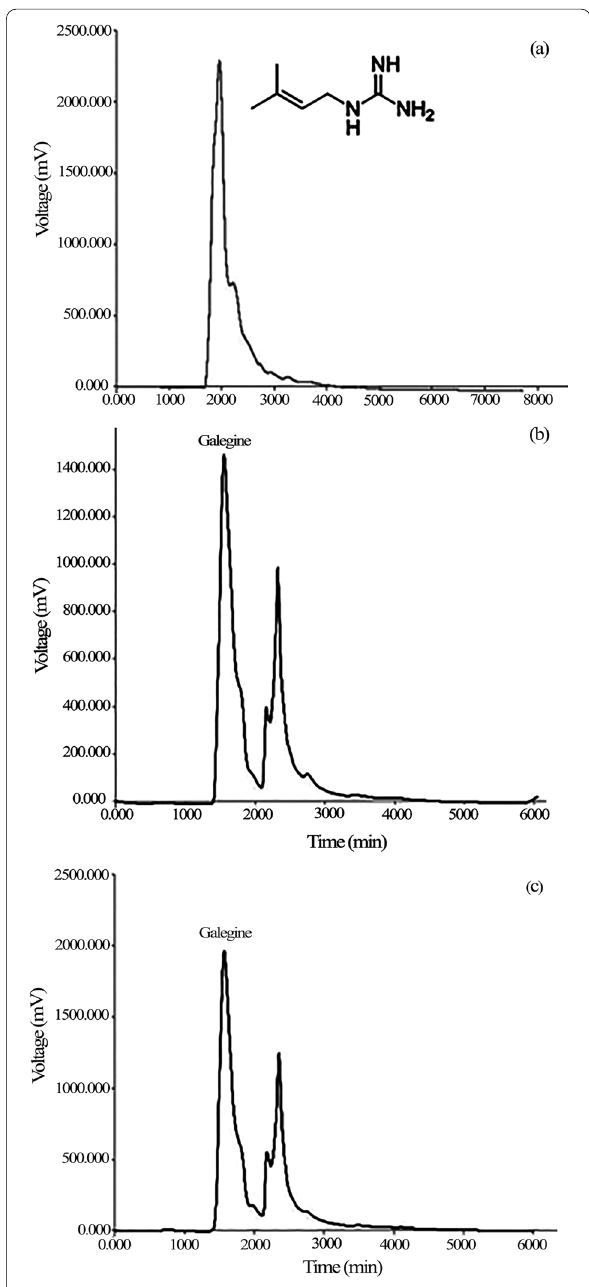
Fig. 9 HPLC chromatogram showing galegine standard ( a ) galegine content in untreated hairy roots ( b ), and in roots treated with ultrasonic waves for 4 min in hairy root culture of G. officinalis ( c